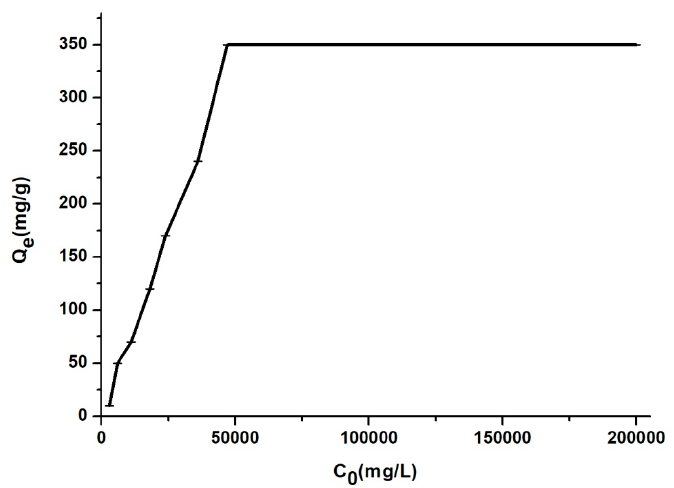
Figure 7. The influence of drug concentration onto MSN.